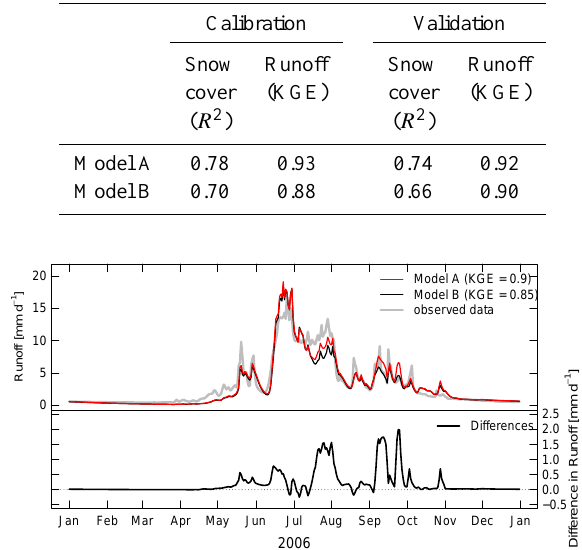
Figure 7. Specific runoff at the outlet at Huben is modelled with (model A) and without (model B) the snow redistribution routine.